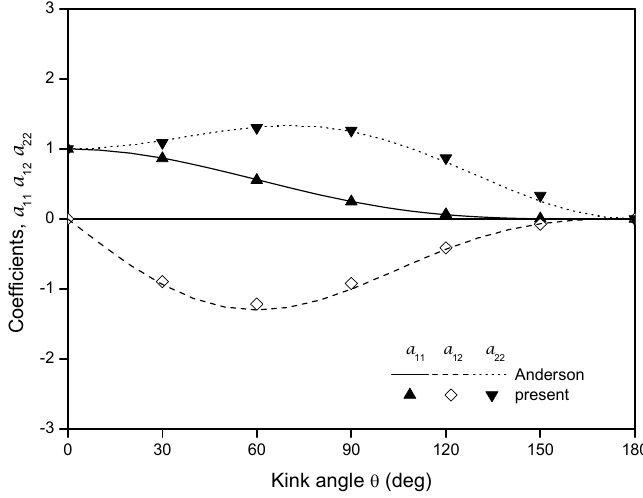
Figure 8. Coe ffi cients of energy release Figure 8. Coefficients of energy release rate.